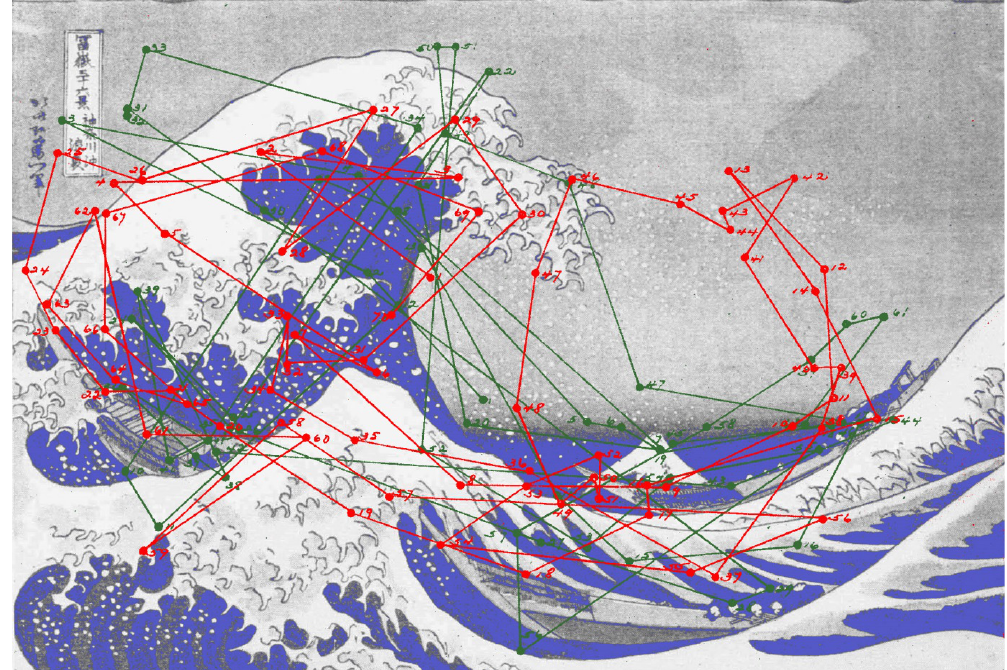
Figure 7. Waves of eye movements 3 . Eye movement records when viewing The Wave by Hokusai. Each colour (red and green) represents the sequential fixations made by two observers. The lines indicate the saccades that moved the eye from one fixation to the next. (Adapted from Picture 13 and Plates XXXII and XXXIII in Buswell,